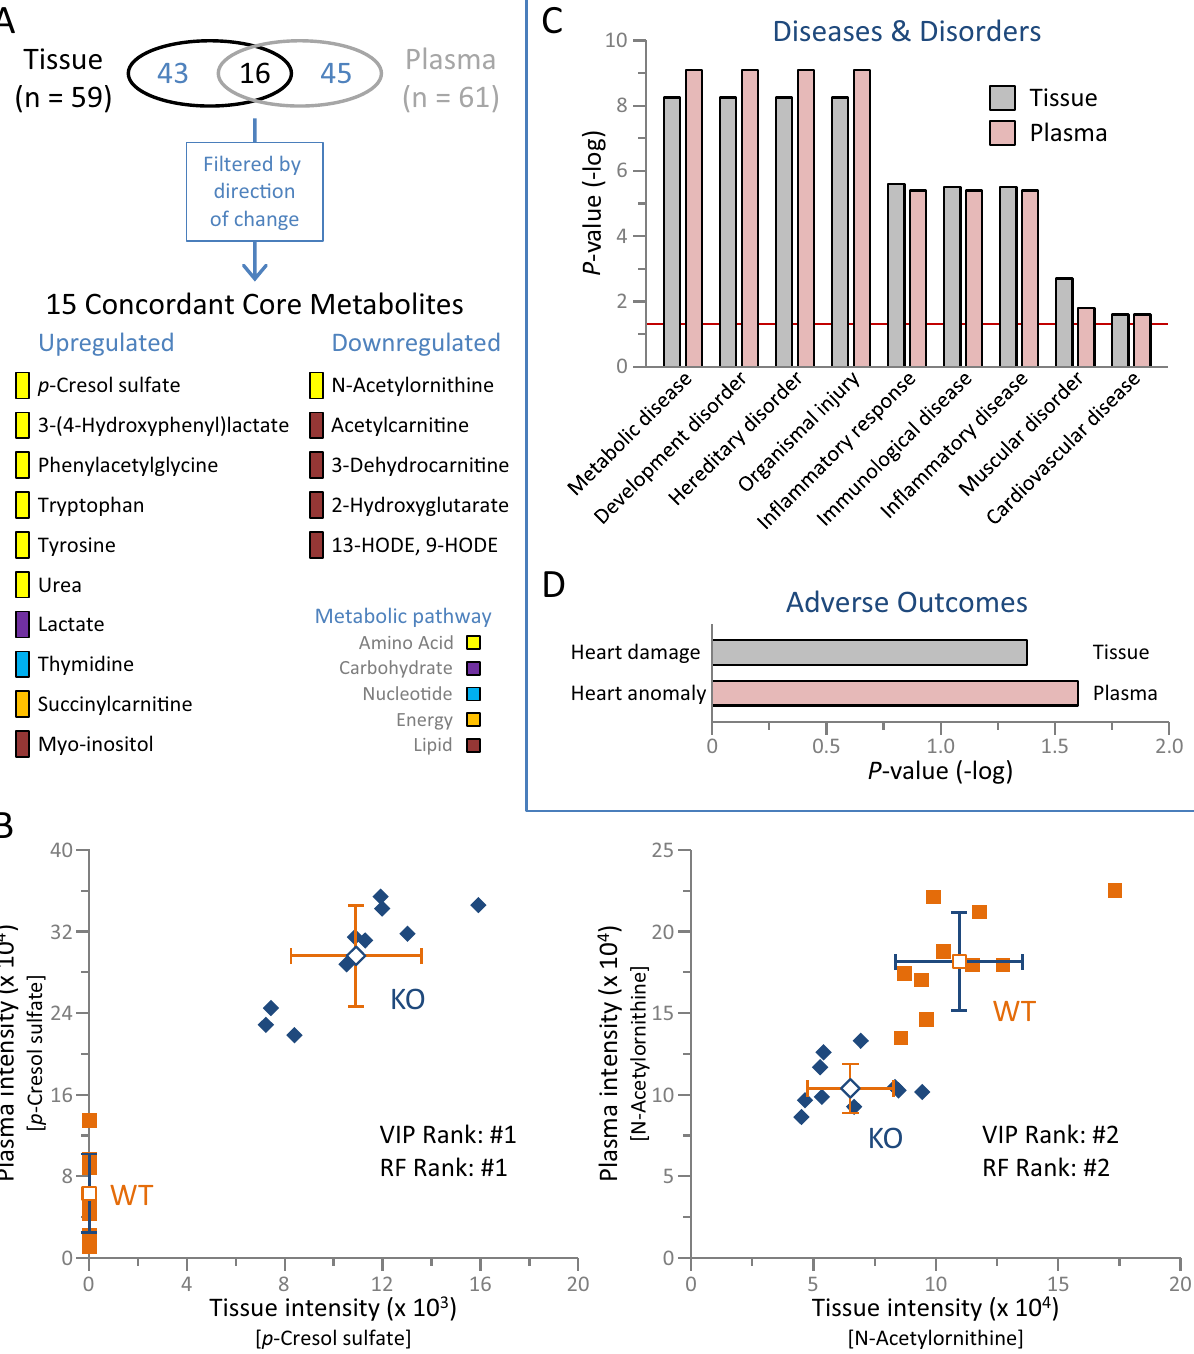
Figure 9. Concordant Kir6.2 knockout plasma and tissue metabolome. ( A ) Overlap between tissue and corresponding plasma of Kir6.2 knockout (KO; n = 10) versus wildtype (WT; n = 10) metabolomes identified 15 shared concordant differential metabolites. Overlapping core metabolites are members of distinct metabolic pathways, primarily associated with amino acid and lipid metabolism. ( B ) WT and KO plasma and tissue spectral intensities were cross-referenced for p -cresol sulfate (left) and N-acetylornithine (right), the top ranking metabolites upregulated and downregulated in KO versus WT as modeled by soft independent modeling of class analogy variable importance in projection (VIP) scoring and Random Forest (RF) classification. ( C ) Plasma and tissue Kir6.2 dependent metabolomes yielded matching disease and disorder profiles, with ( D ) equivalent magnitude of predicted cardiovascular adverse